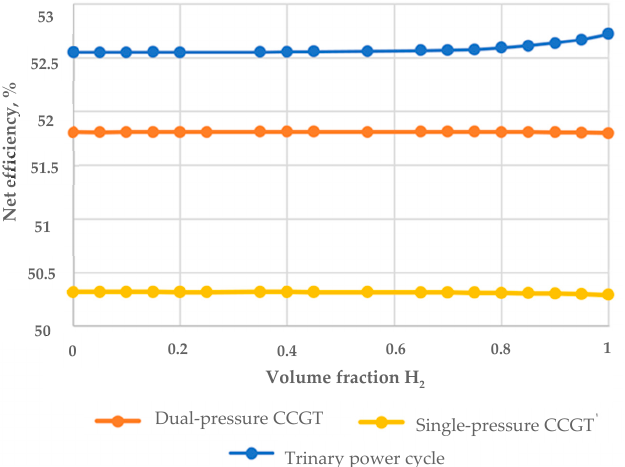
Figure 15. Comparison of energy efficiency when operating on methane–hydrogen fuel of a double- circuit and single-circuit CCGT.